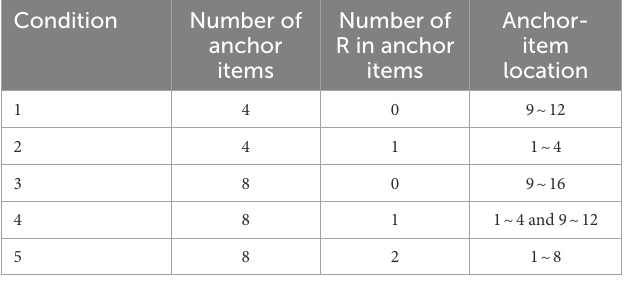
TABLE 1 Anchor-item settings in Study 1. Condition Number of